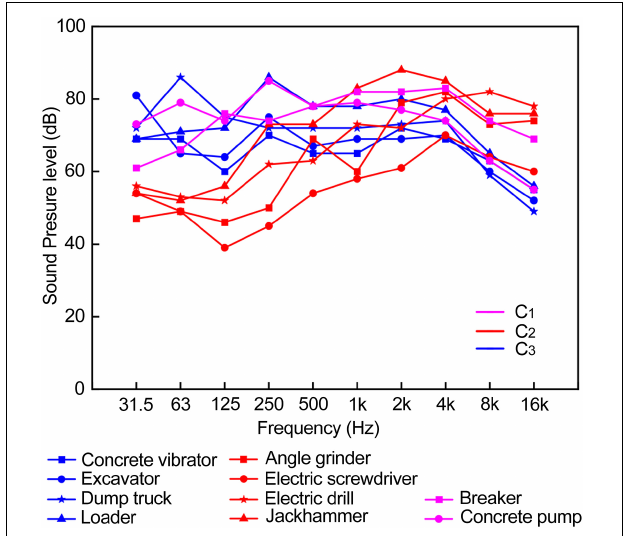
FIGURE 6 | Frequency spectrums of 10 typical